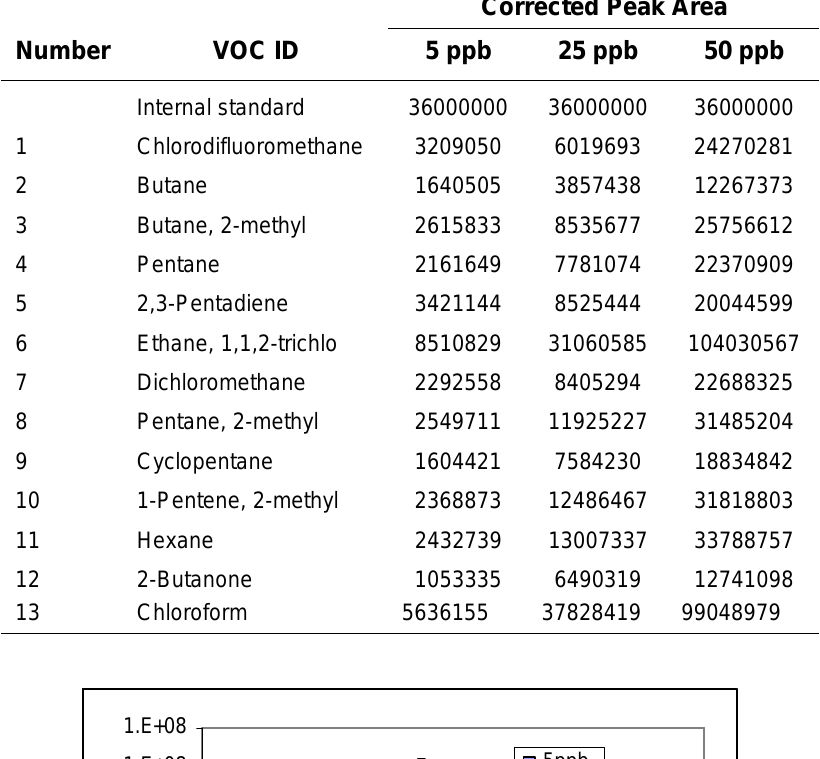
Comparison of Corrected VOCs Peak Areas and Internal Standard Peak Areas at Three Concentration Levels Corrected Peak Area